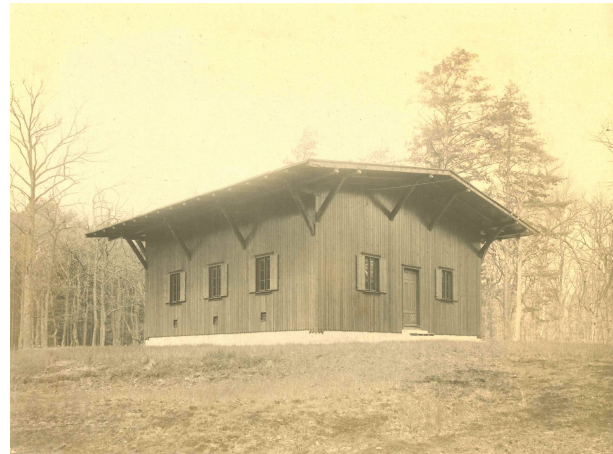
Figure 3. Photo of the Seddin Observatory building. Source: Helmholtz Centre Potsdam – GFZ.